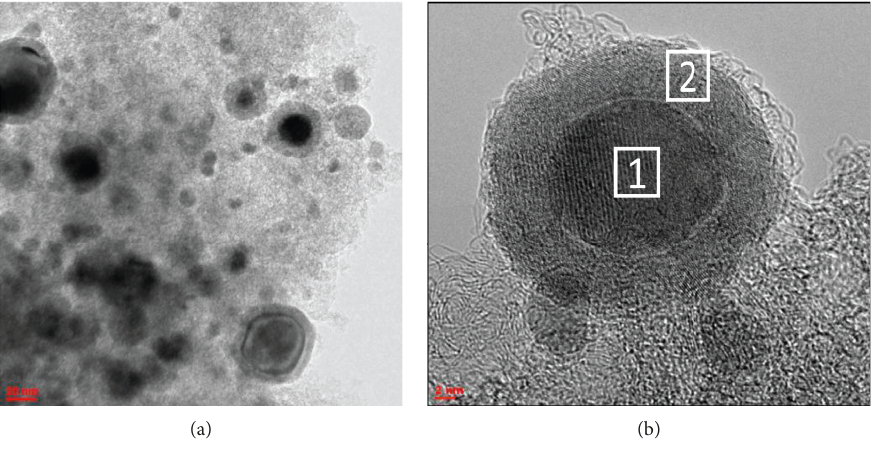
Figure 4: (a, b) Micrographs of active components after the reaction.